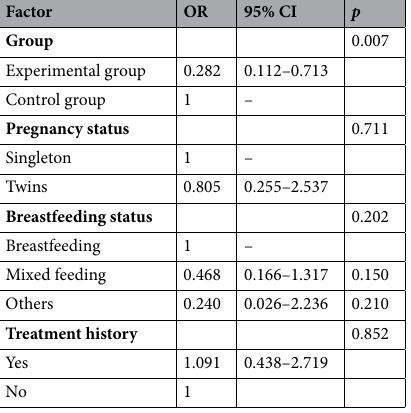
Table 3. Multivariate logistic regression analysis of the factors influencing the cure rate on day-5. CI, confidence interval; OR, odds ratio.